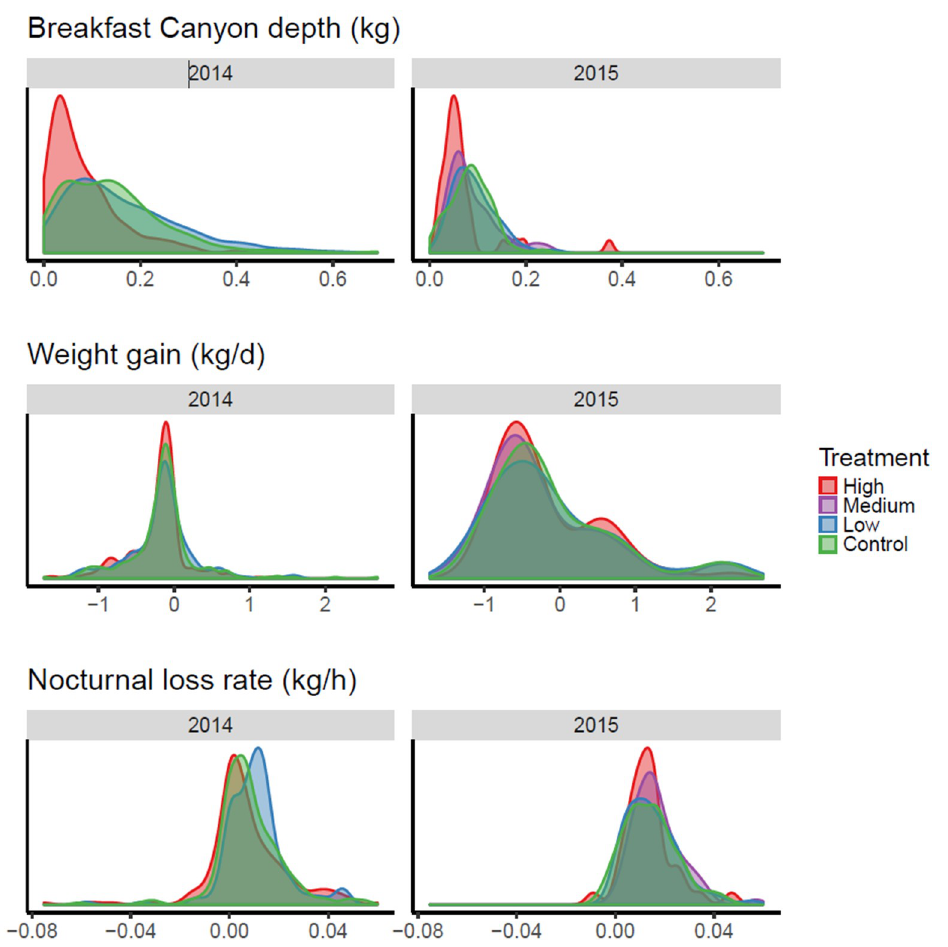
Figure 6. Density plots of daily parameter values estimated in the period after pesticide treatment. The area under each curve equals one. In 2014 there was no medium treatment. Formal statistics presented in File S1: Section 1.